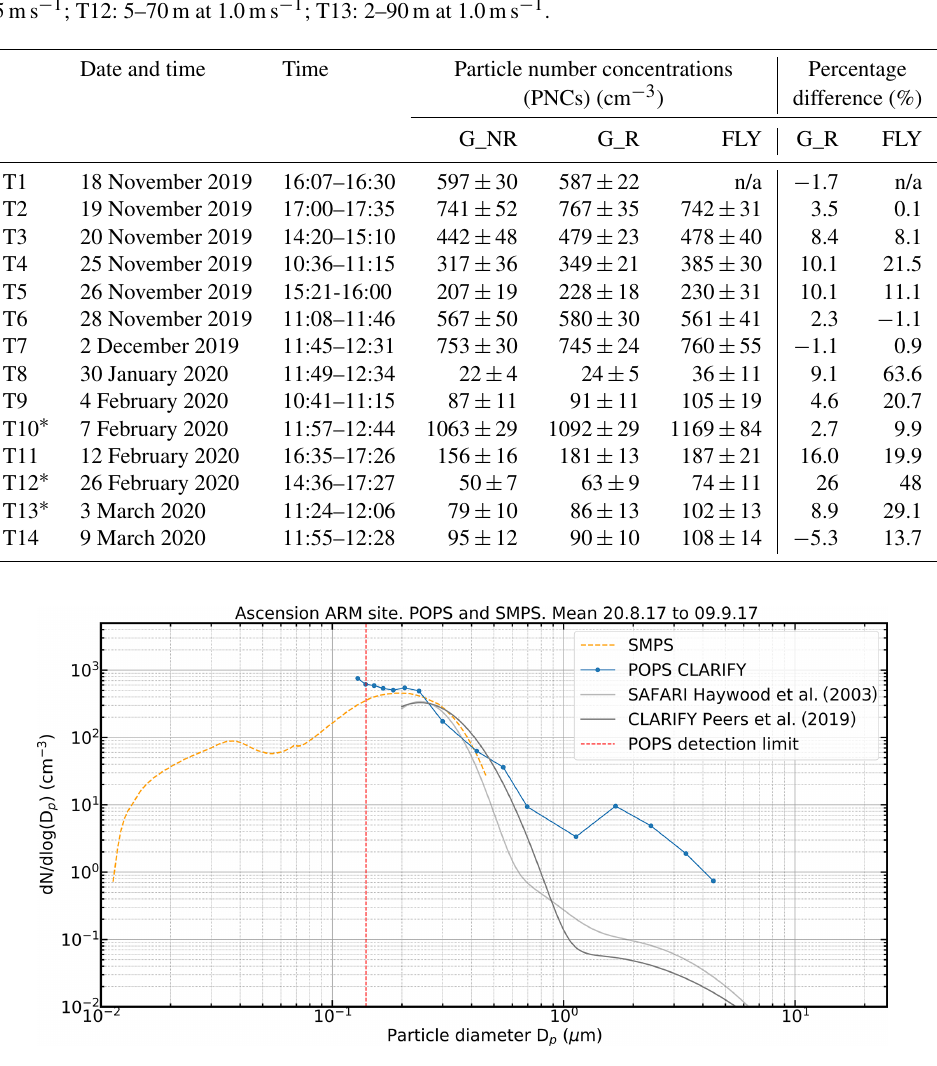
Figure 2. PSDs from POPS, SMPS, and data fitted to a wing-mounted PCASP from CLARIFY-2017 and SAFARI-2000. POPS and SMPS data were collected at the ARM mobile site on Ascension Island from 20 August to 9 September 2017. The PCASP data from CLARIFY were collected from a flight on 4 September 2017 (Peers et al., 2019). The PCASP data from SAFARI-2000 represent a mean from 11 flights performed off the coast of Namibia (Haywood et al., 2003b). Note that the CLARIFY-210 and SAFARAI-2000 PCASP distributions are “scaled” to the SMPS size distribution to aid comparison. The POPS and SMPS values are not